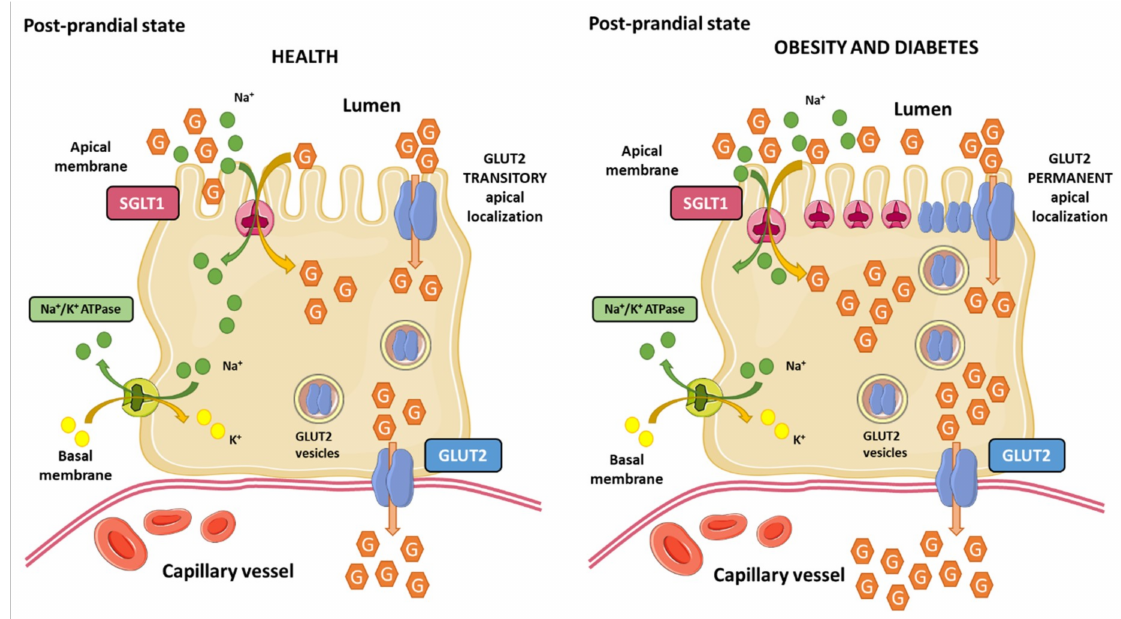
Figure 3. Glucose transport in enterocytes in health and disease. ( Left panel ): After a meal, luminal glucose ( G ) is transported across the apical membrane by SGLT1, and the Na + is then transported out the enterocyte through the basolateral membrane by the Na + / K + -ATPase. Glucose is phosphorylated and accumulates within the cell. Dephosphorylated glucose passively is transported out of the cell through the basolateral membrane by GLUT2. Alternatively, in response to high glucose luminal concentrations, a pool of endosomal GLUT2 is rapidly and transiently translocated to the apical membrane leading to increased glucose uptake. ( Right panel ): In the setting of obesity and / or diabetes, insulin resistance provokes the loss of GLUT2 tra ffi cking control leading to a permanent localization of GLUT2 in the apical and / or endosomal enterocyte membranes and to increased transepithelial glucose transport from lumen to blood circulation. This figure was created using Servier Medical